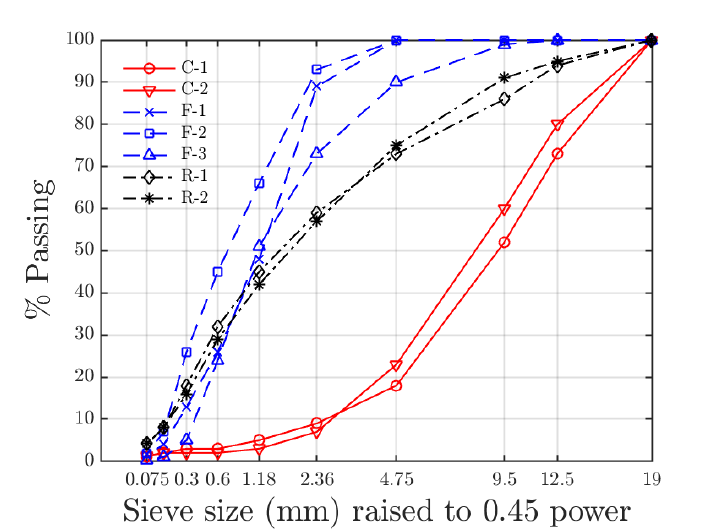
Figure 3. Gradation of aggregate sources. The line colors and styles indicate the type of aggregate.